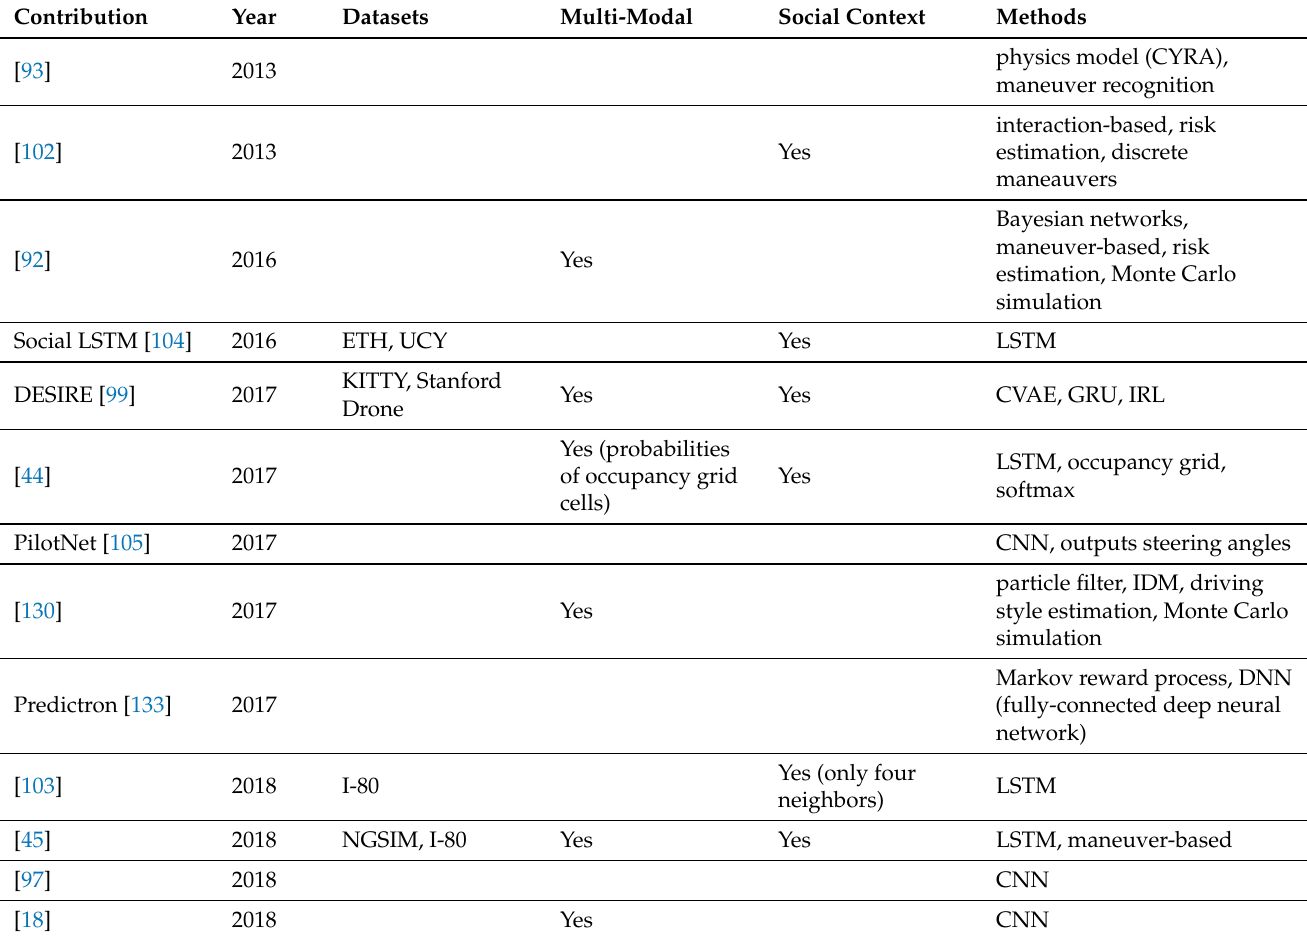
Table 2. Overview of trajectory prediction